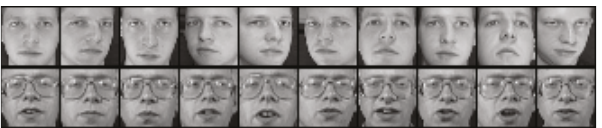
Figure 3: Example face images of two subjects from the ORL data set.